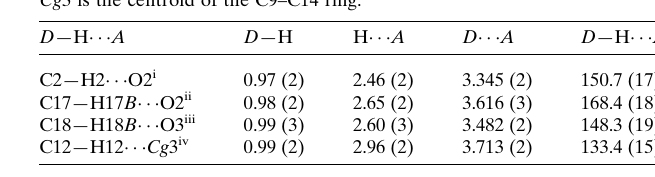
Table 1 Hydrogen-bond geometry (A˚ , (cid:4) ).